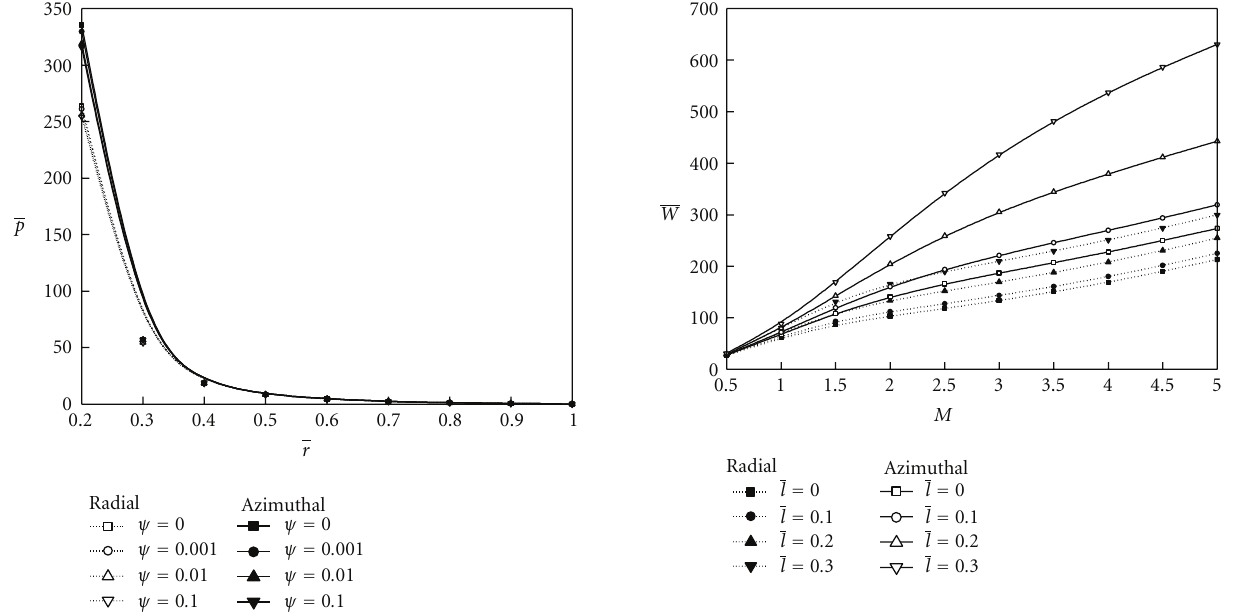
Figure 5: Variation of nondimensional mean film pressure p with r for di ff erent values of ψ with β = 0 . 05, M = 2, l = 0 . 3, and c = 0 . 3.